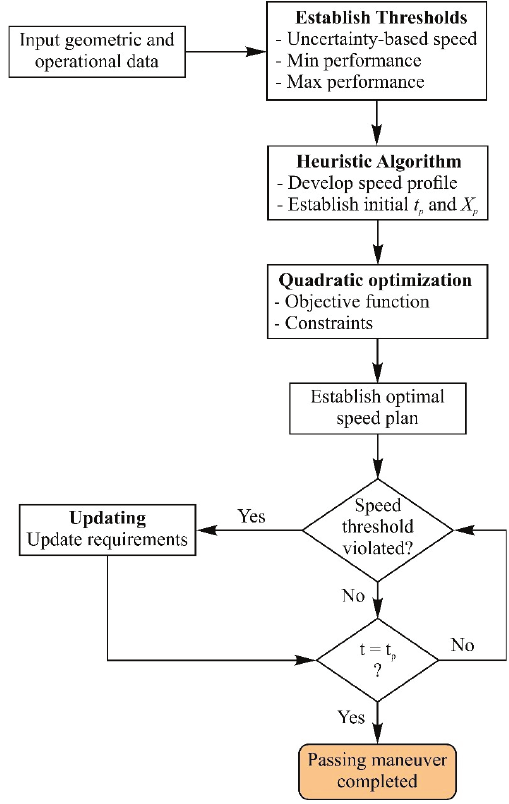
Figure 2. Logic of the proposed speed control model for the overtaking of autonomous vehicles.